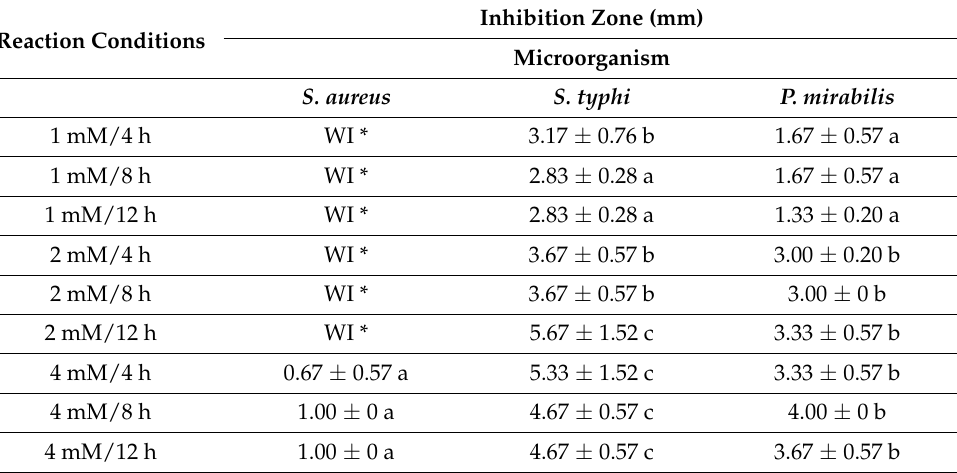
Table 3. Inhibition zone of AgNPs synthetized by pecan nutshell extract to different reaction condi- tions against S. aureus , S. typhi and P. mirabilis